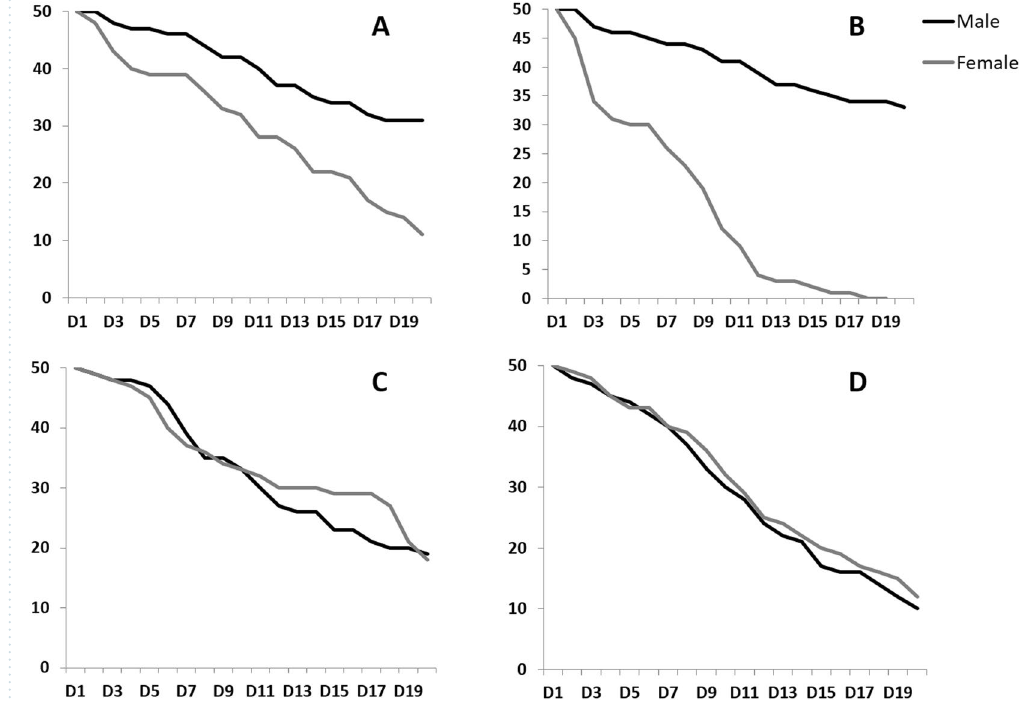
Figure 1. Adult longevity when raised on diet without or with limited tetracycline. For all tests the cages contained 50 adult males and 50 adult females at day 0. ( A ) DH1 on diet without tetracycline; ( B ) DH2 on diet without tetracycline; ( C ) DH1 on limited tetracycline (10 ug/ml for 2 d); ( D ) DH1 on limited tetracycline (10 ug/ml for